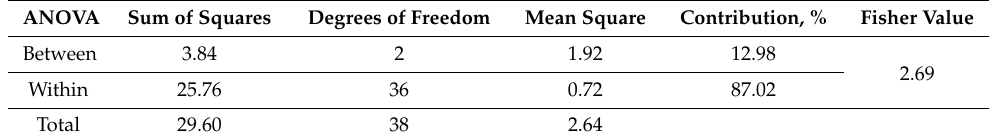
Table 4. Comparison between Groups A, B and C in T0-T1.